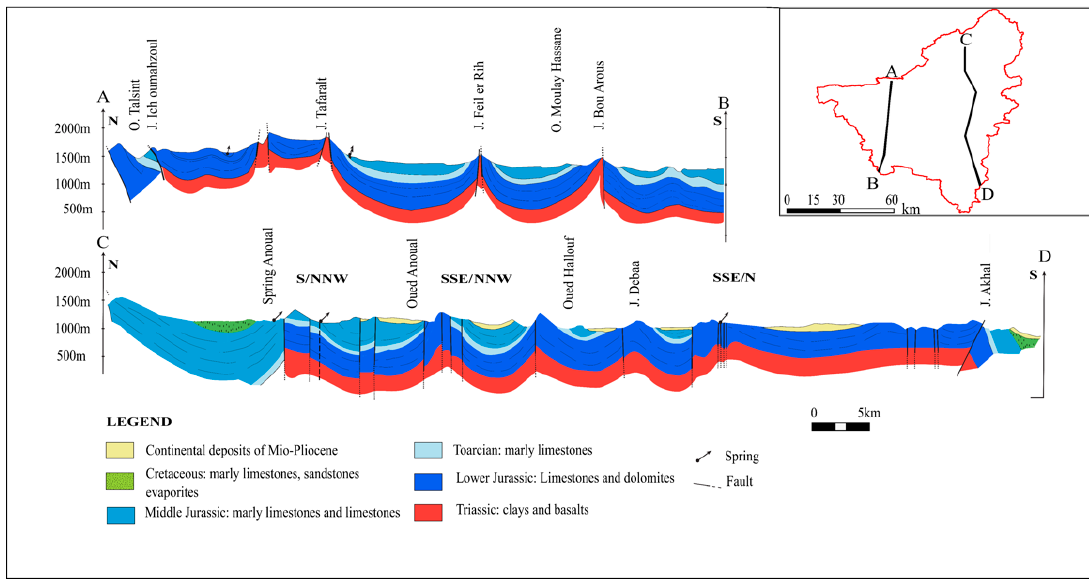
Figure 4. Geological cross-sections showing the structure of High Atlas compartmented by parallel folds, faulted anticlines and thrust faults (modified from [24]).